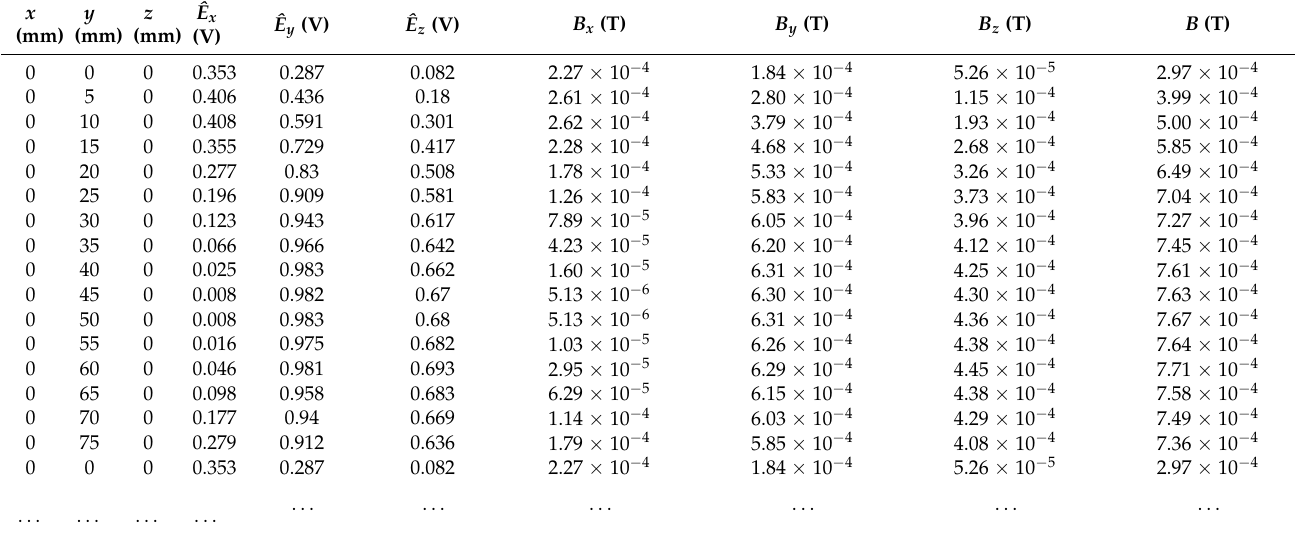
Table 4. Magnetic flux density measurements of the DD